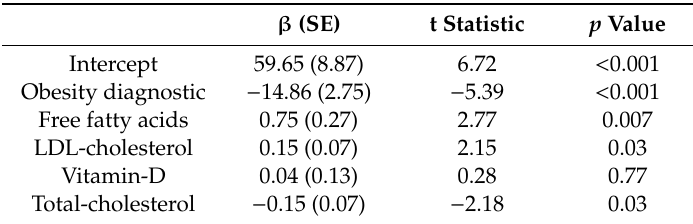
Table 2. Estimated coe ffi cients ( β ) of the multivariate linear regression model of the cross-sectional study population, with standard error (SE), t statistic and p